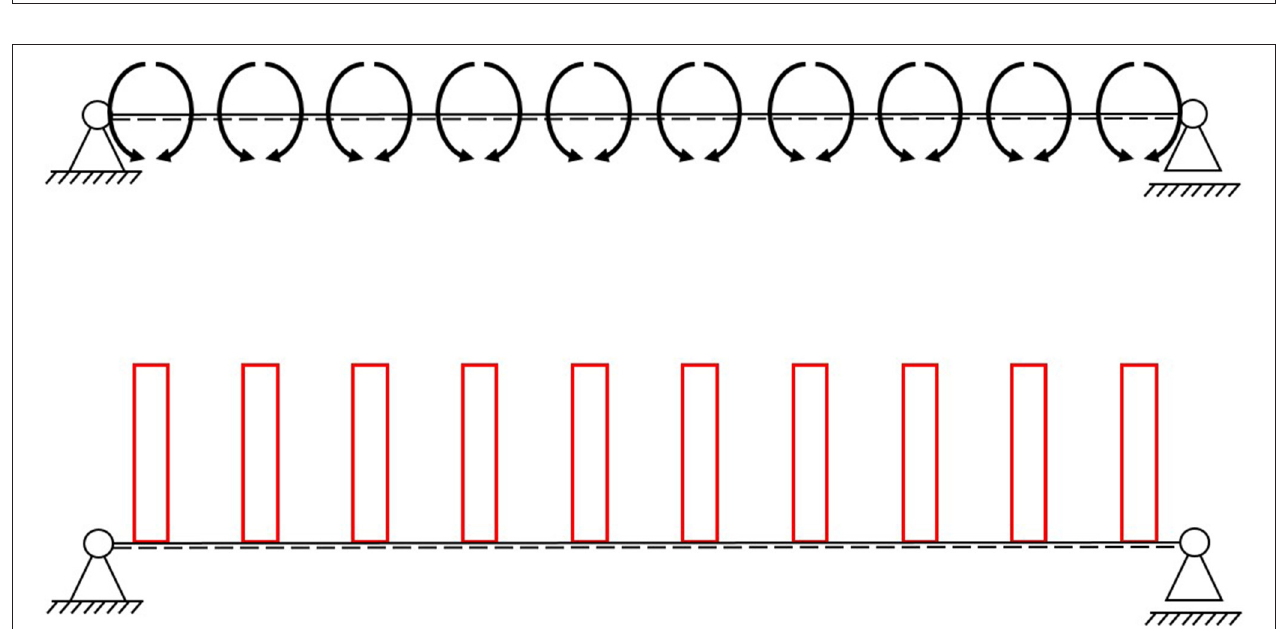
FIGURE 3 | Single-span beam with 10 actuators with the same hydraulic pressure (Top) and the theoretical bending moment diagram (Bottom)